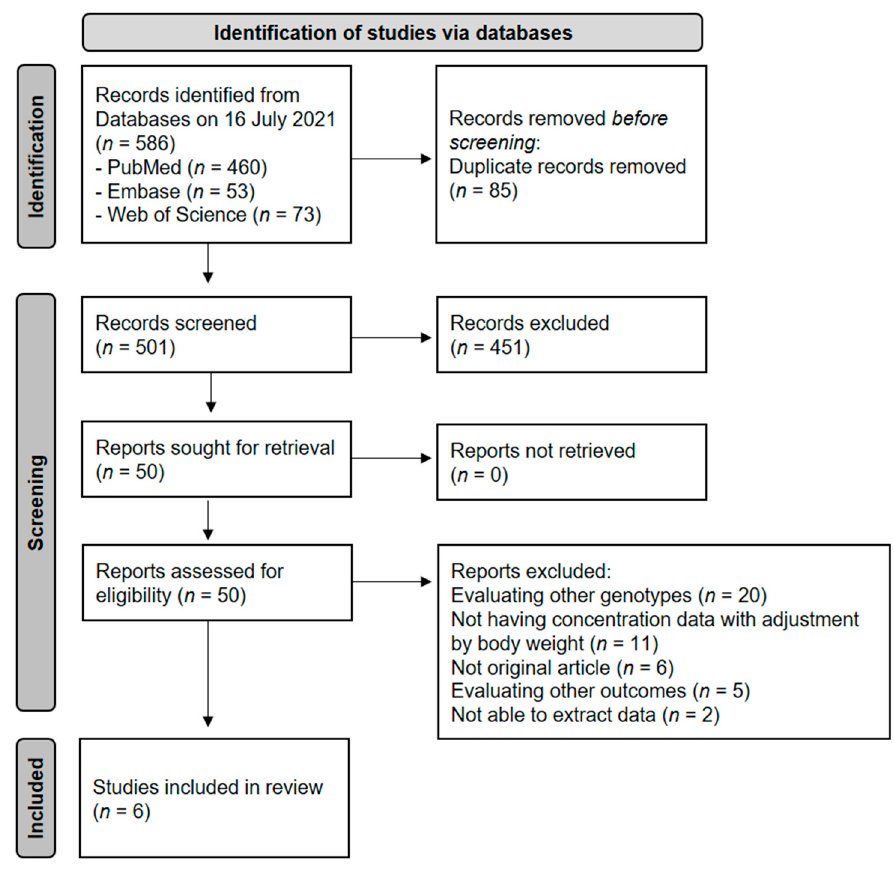
Figure 1. A flow diagram of study selection. Table 2. The characteristics of included studies.